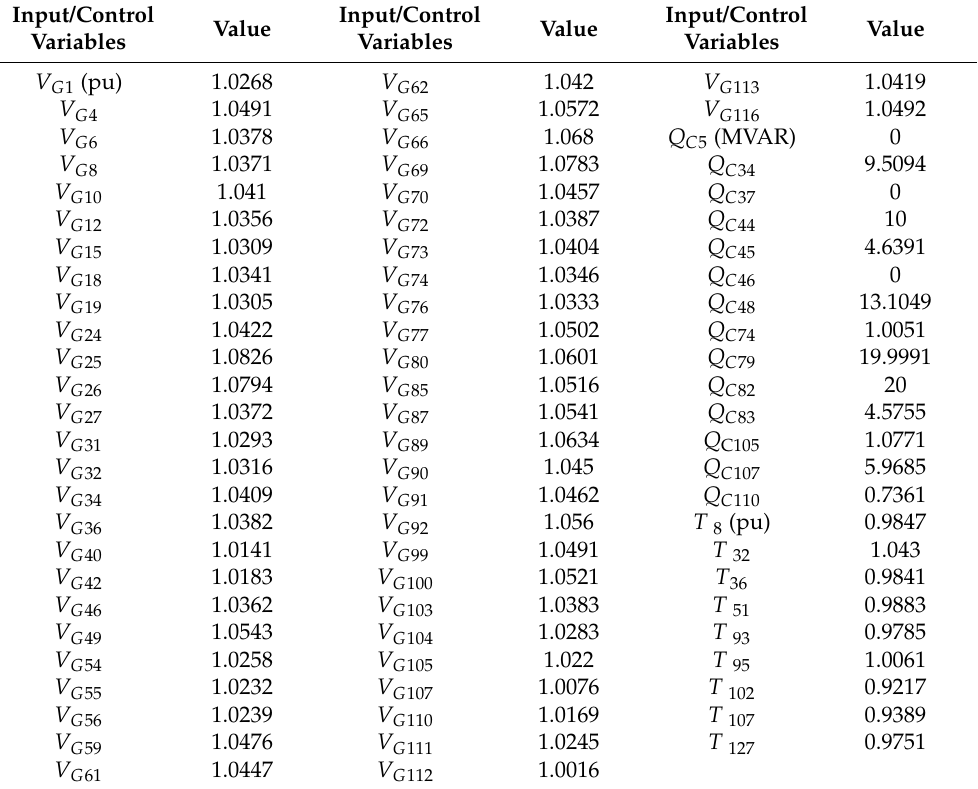
Table A3. Optimal solution obtained by ICOA for TPL objective of the IEEE 118-bus power system with the case of continuous